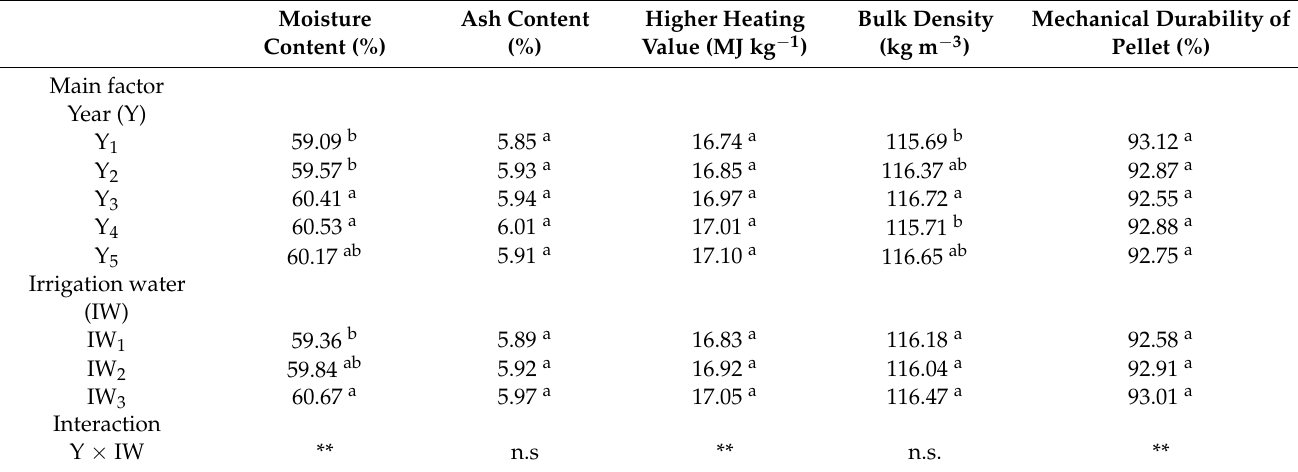
Means followed by the same letter in the same column are not significantly different according to Tukey’s test ( p ≤ 0.01). ** significant at p ≤ 0.01; n.s. = not